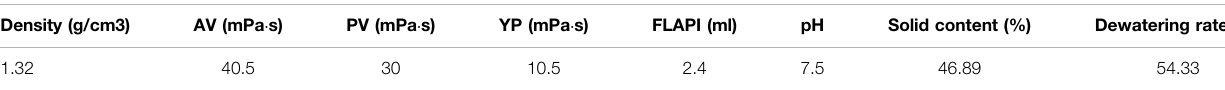
TABLE 1 | Biodrill-A drilling fl uid basic performance and colloidal stability characteristics. Density (g/cm3)